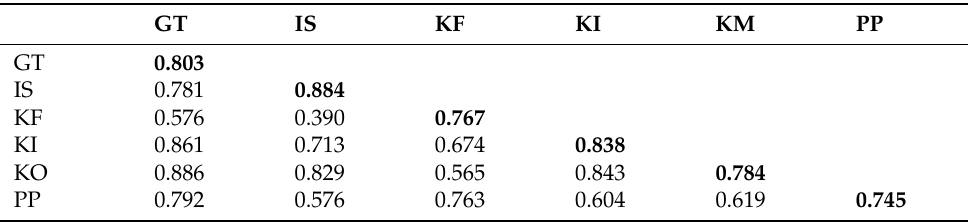
Table 5. Variable correlations.